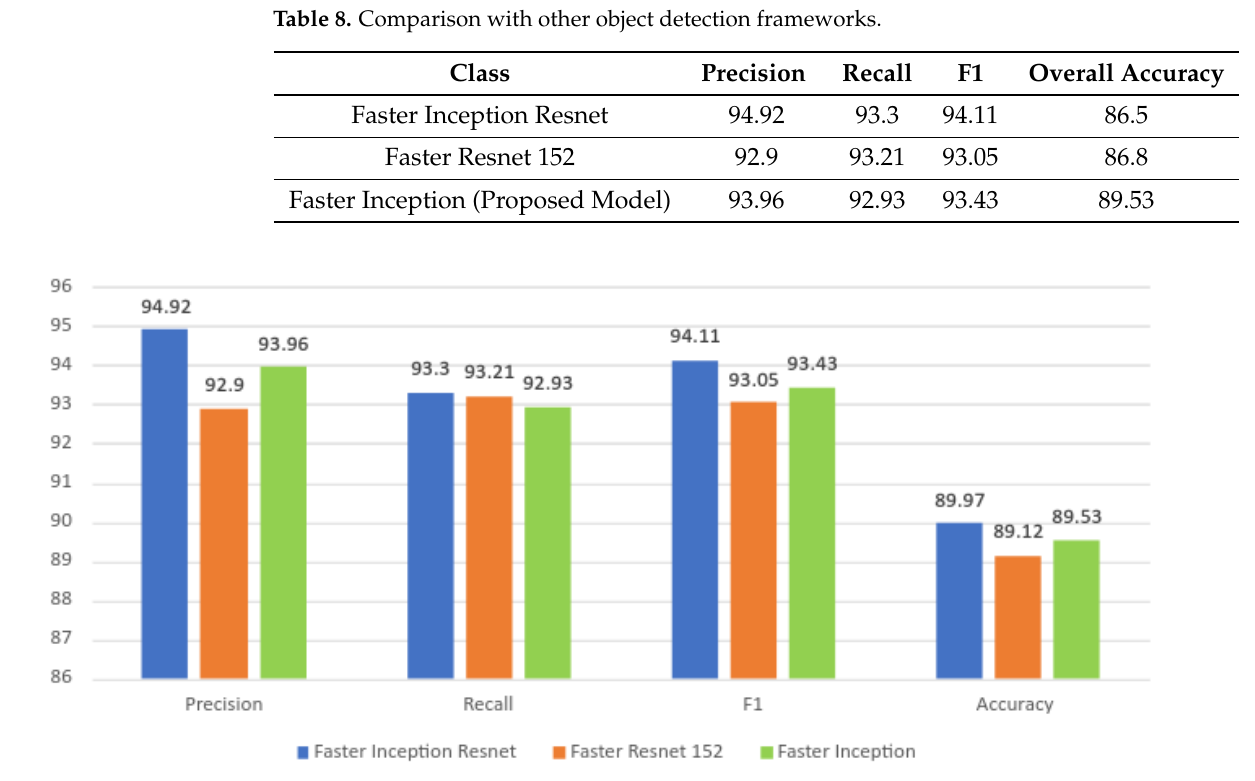
Figure 14. Graphical representation of the comparison with other detection frameworks.